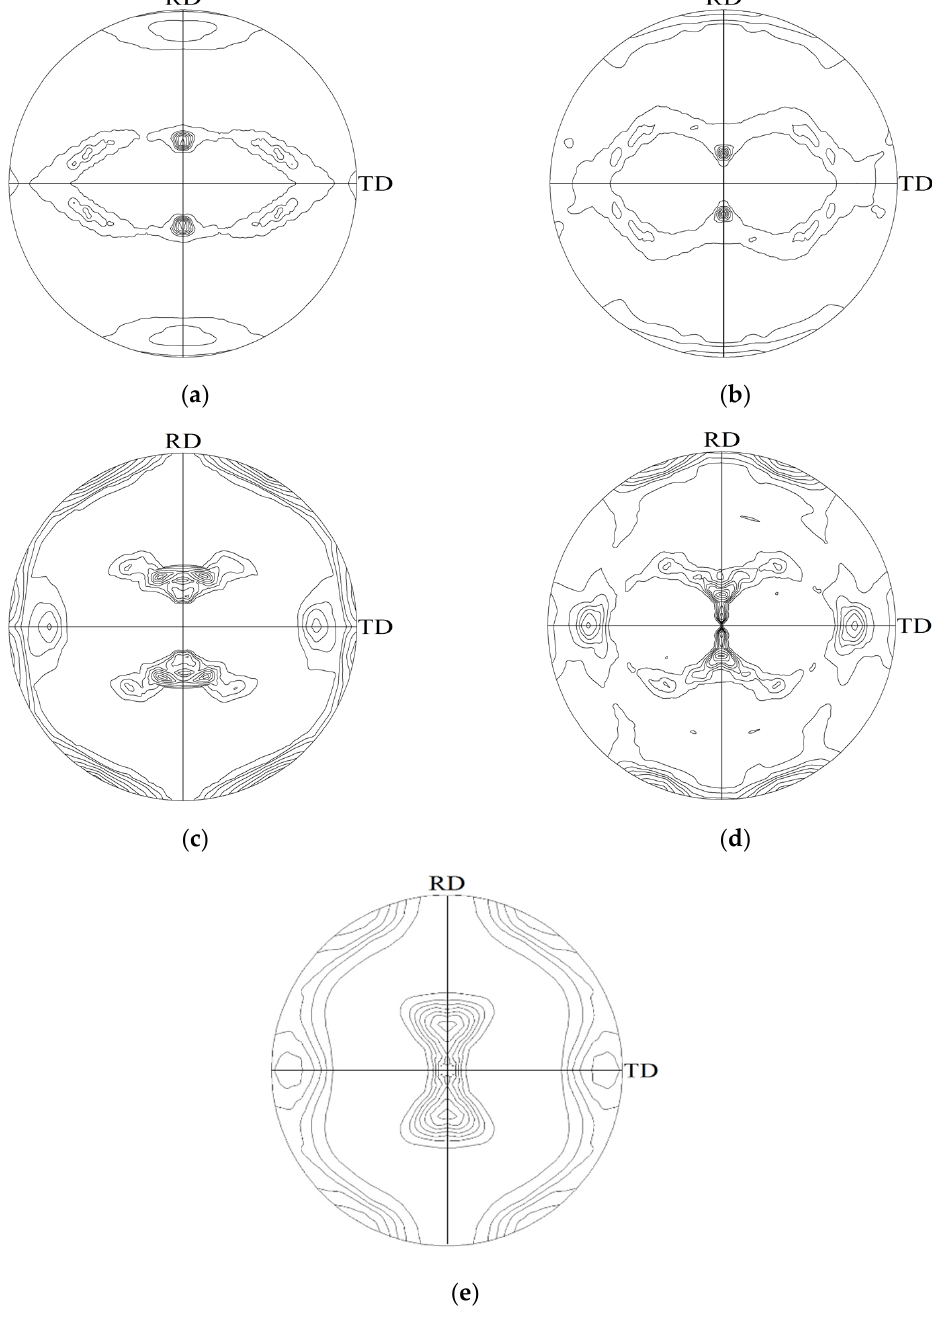
Figure 3. The {1 1 1} pole figures of fcc metals simulated using ( a ) FC-, ( b ) RC-, ( c ) MT-, and ( d ) MTCS-models with random orientations up to 90% reduction and ( e ) after 90% cold-rolled in Cu–30%Zn alloy obtained from XRD measurements.